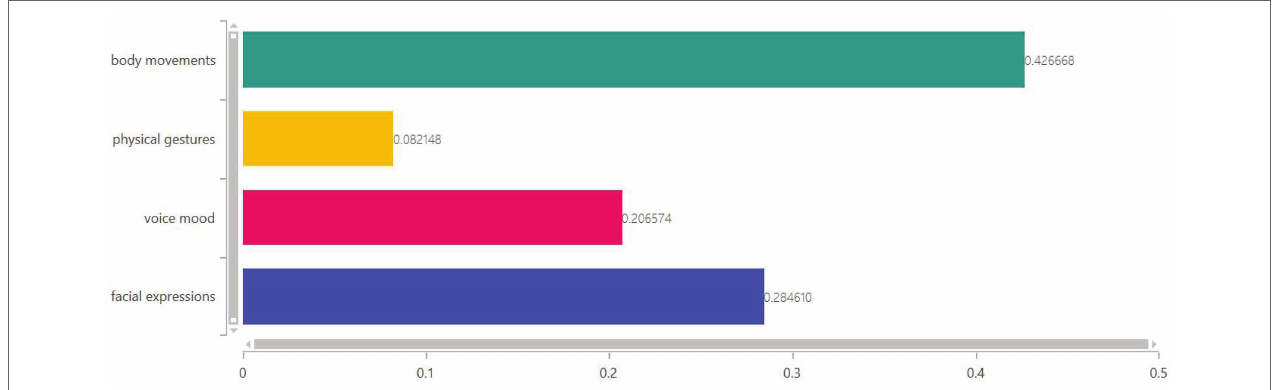
FIGURE 2 | Weight of each factor. The abscissa is the weight of each